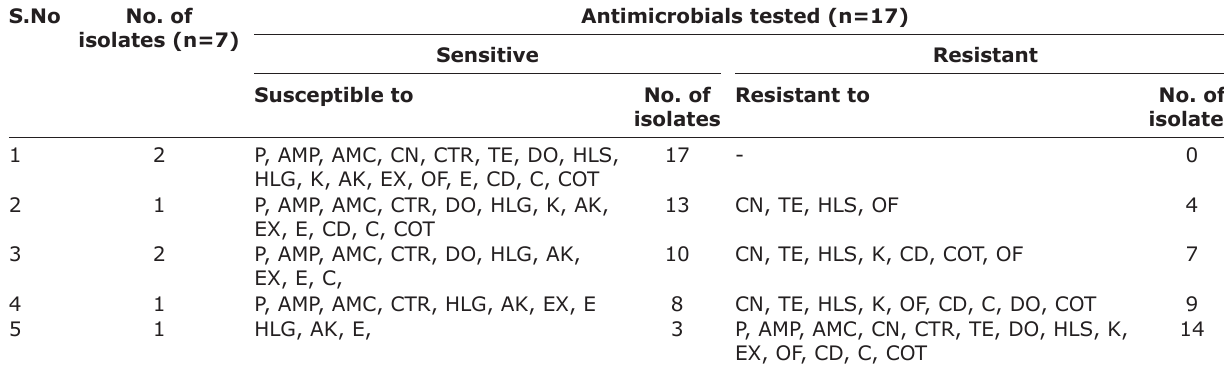
Table-3: Antimicrobial resistance pattern (s) of Streptococcus suis . S.No No. of isolates